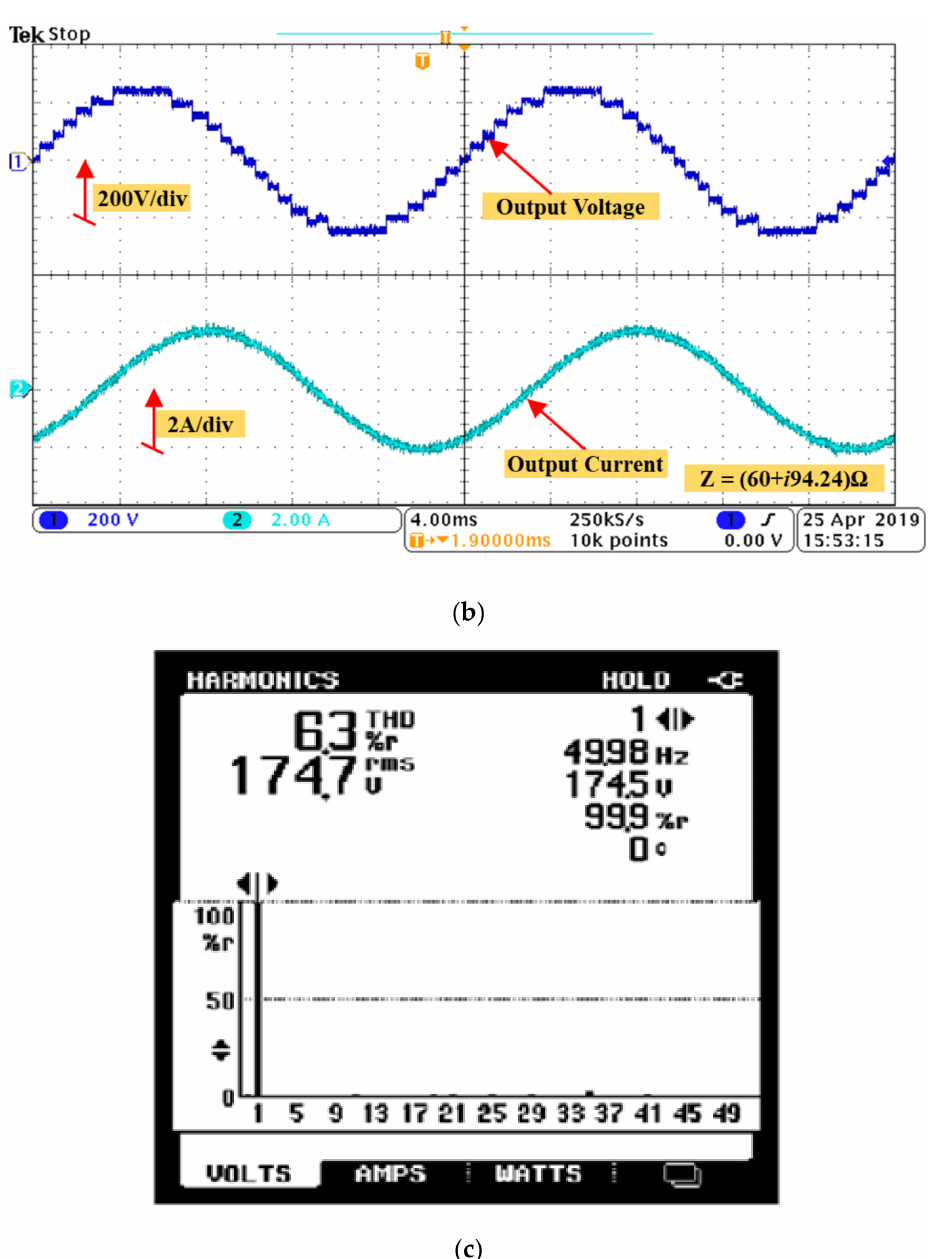
Figure 10. Terminal voltage and Load current for ( a ) R load and ( b ) R-L load, and ( c ) harmonic spectrum of output